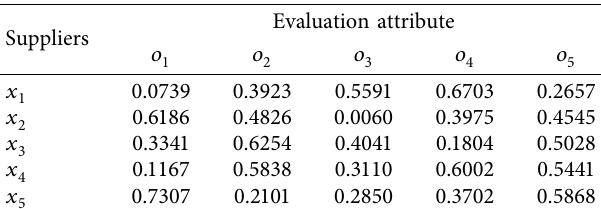
Table 5: Perceived utility function values of attribute values cor- responding to each